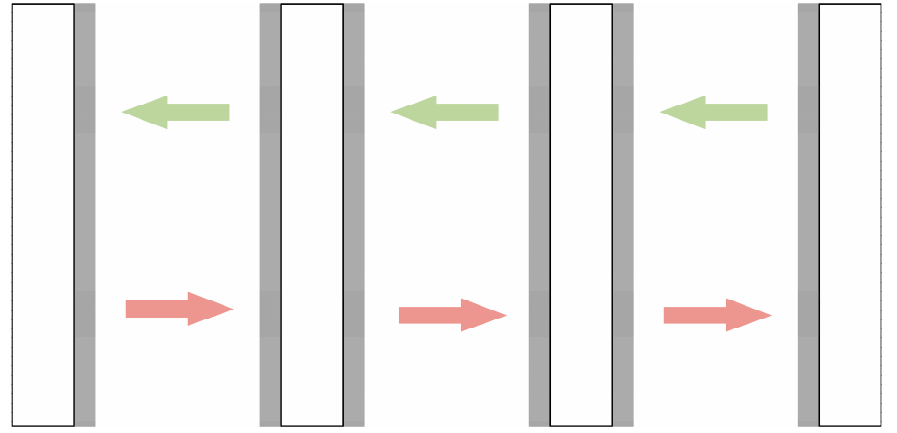
Figure 7. MPI data-transfer method in the case of two-dimensional grids. The shaded part represents the data to be transmitted and received and represents the spatial position of the sub-domain in the two-dimensional space.